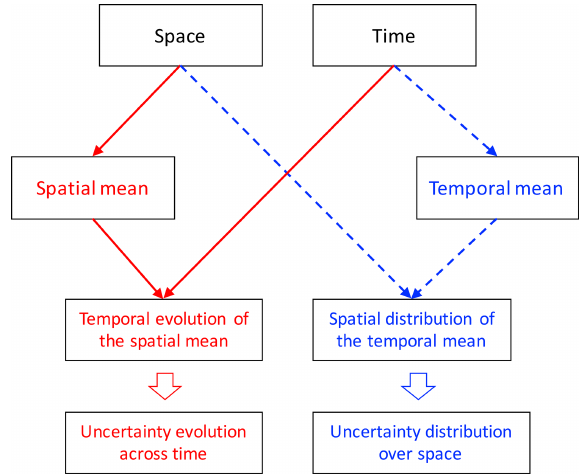
Figure 1. Two classic uncertainty assessments in the current litera- ture: the temporal evolution of the model uncertainty (flowcharts in red) and the spatial distribution of the model uncertainty (flowcharts in blue). Each of these uncertainty estimates was averaged over one of the dimensions, either space or time, which will lead to loss of information about the corresponding